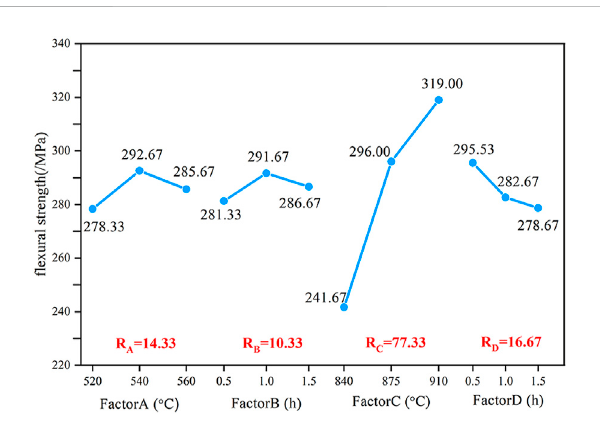
FIGURE 2 In fl uence of various factors on the compressive strength of glass- ceramics: (Factor A) nucleation temperature, (Factor B) nucleation time, (Factor C)crystallization temperature,and (Factor D)crystallization